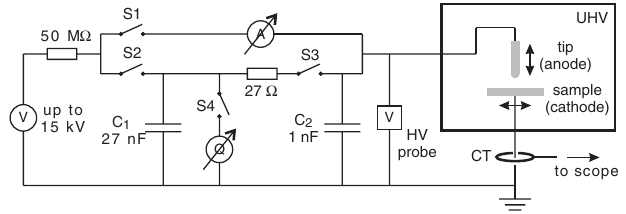
FIG. 1. Schematic drawing of the experimental